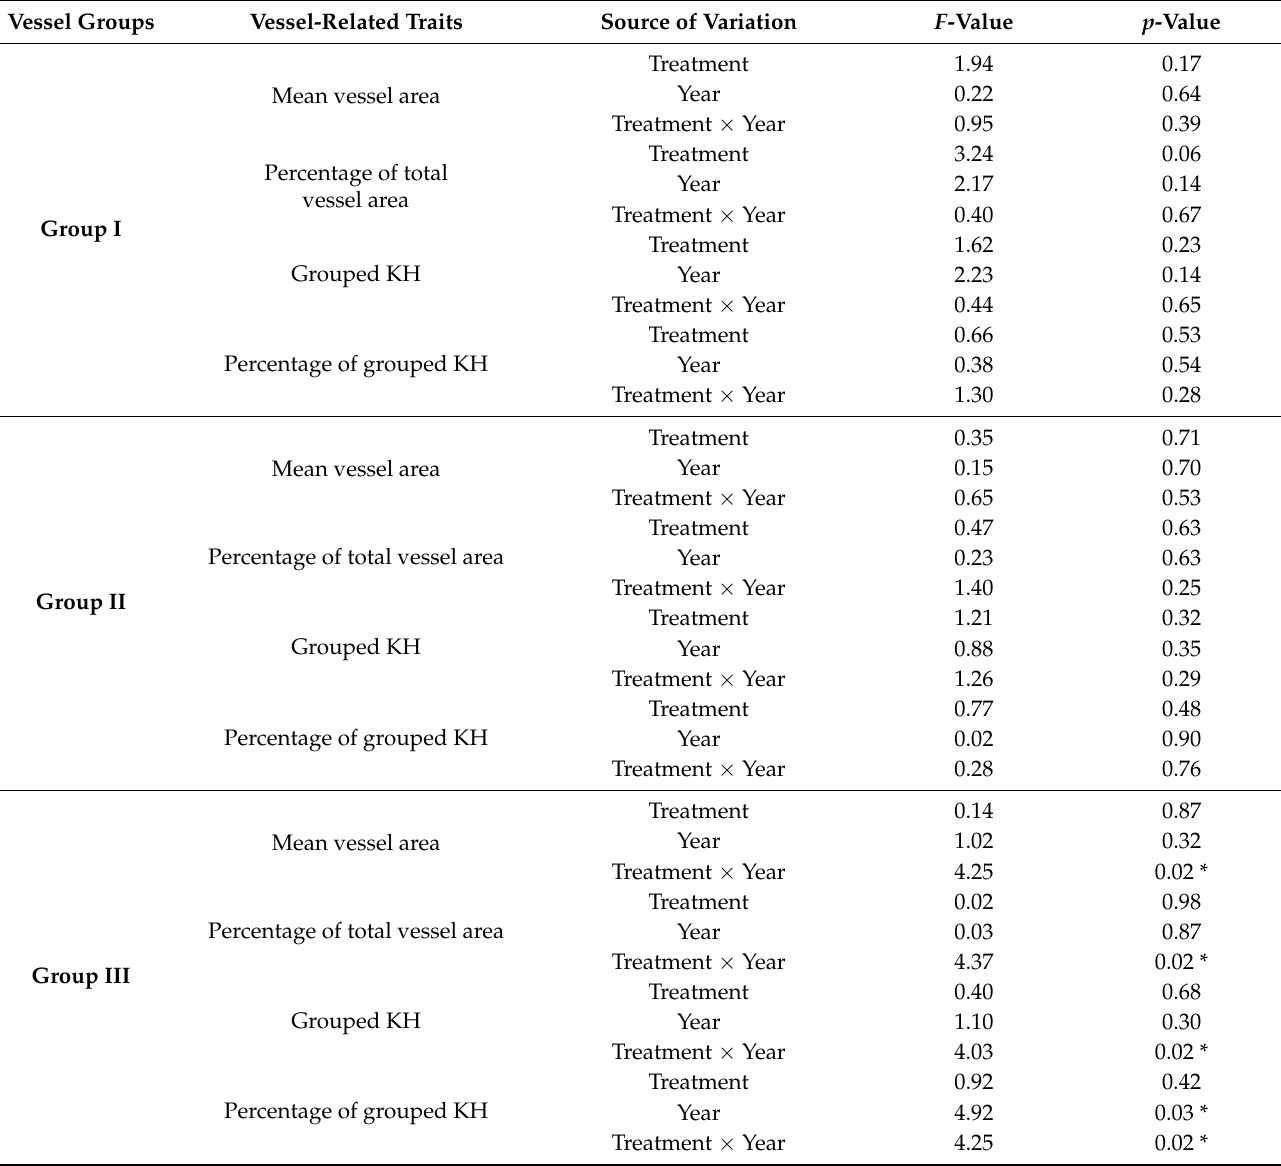
Table 1. ANOVA results showing effects of nitrogen (N) addition treatments, year and their interactive effects on different groups of vessel-related traits in Quercus variabilis Blume during 2013–2018 in Central China.